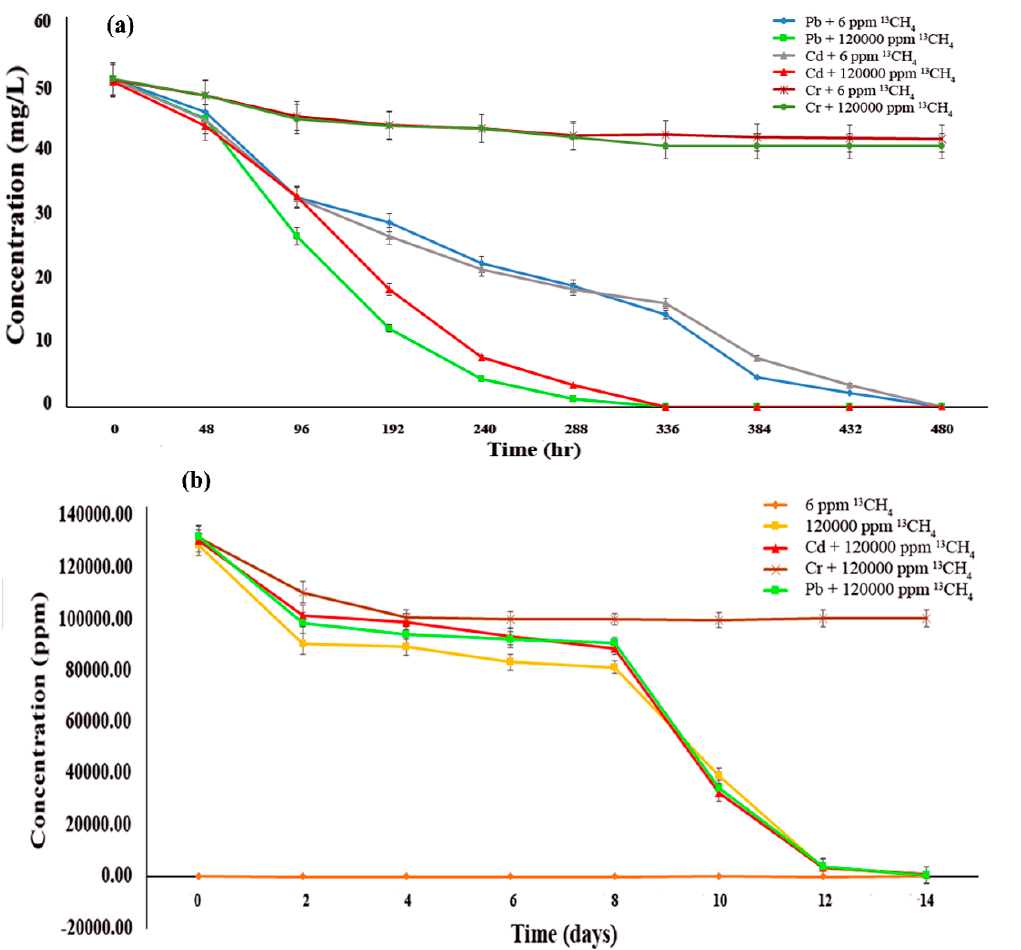
Figure 2. Methane oxidation and heavy metals bioremediation potential of epipelon ( a ) the ability of epipelonic biofilm to remove heavy metals at different time intervals coupled with methane oxidation ( b ) Methane oxidation at different time intervals under heavy metals effect.